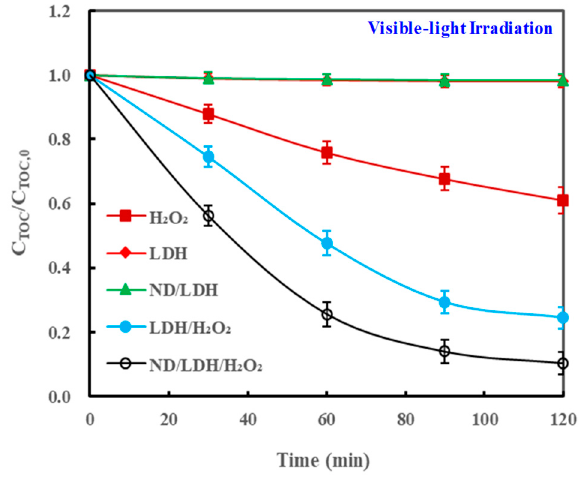
Figure 9. Variation of total organic carbon (TOC) of MB solution during the photodegradation process.